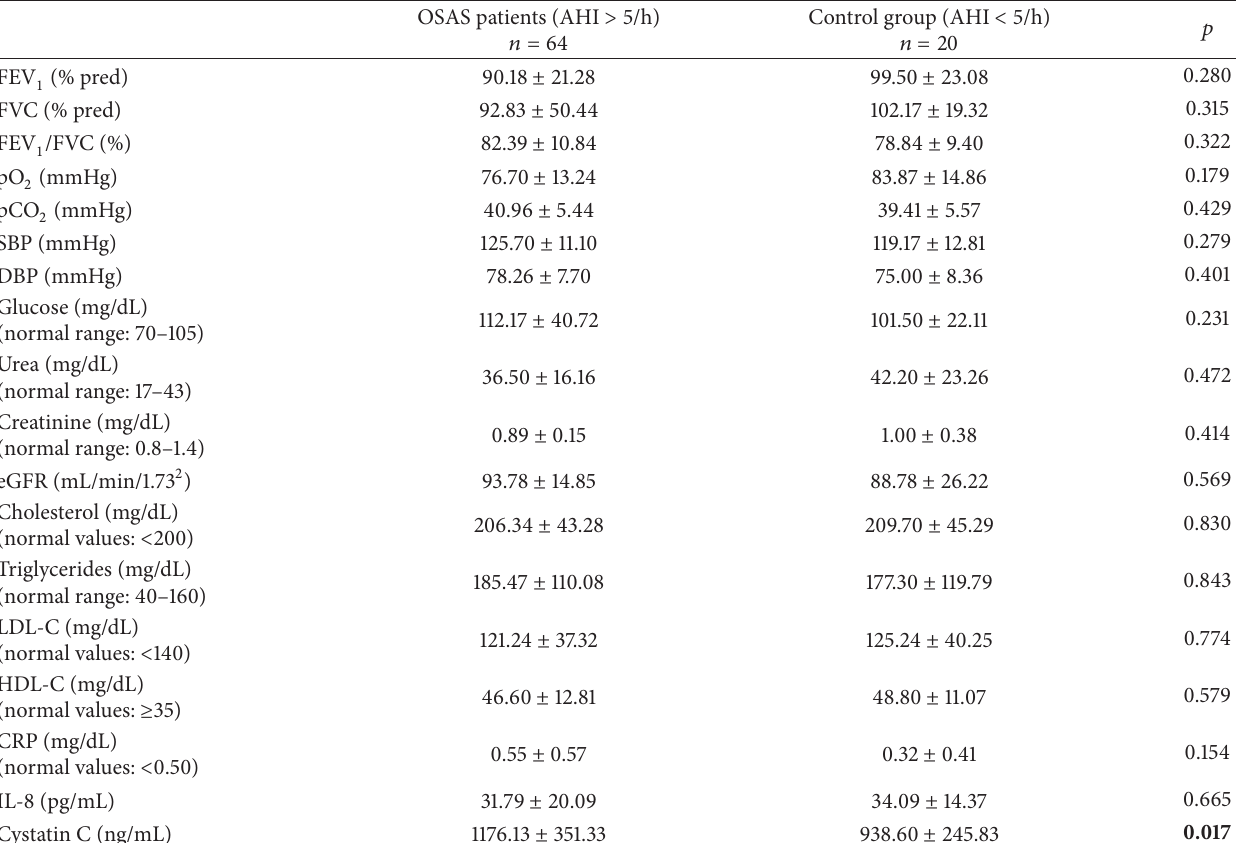
Table 3: Comparison of the laboratory results between OSAS patients and